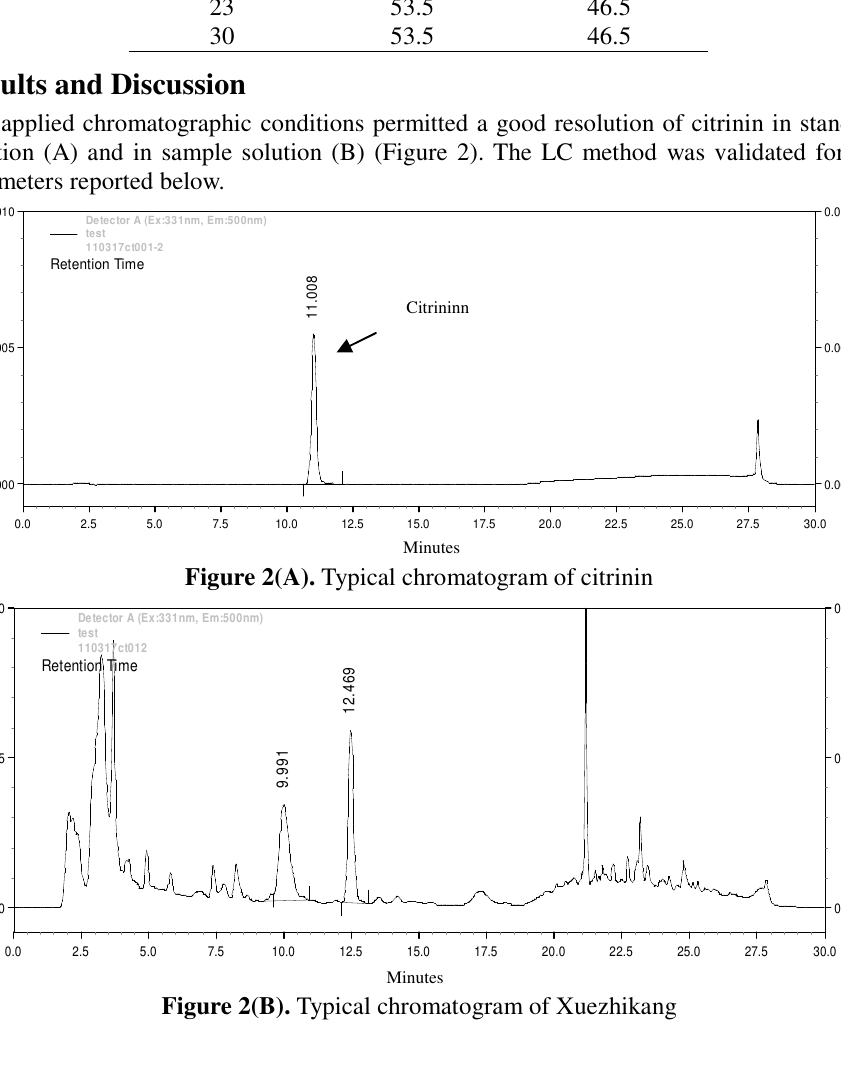
Figure 2(B). Typical chromatogram of